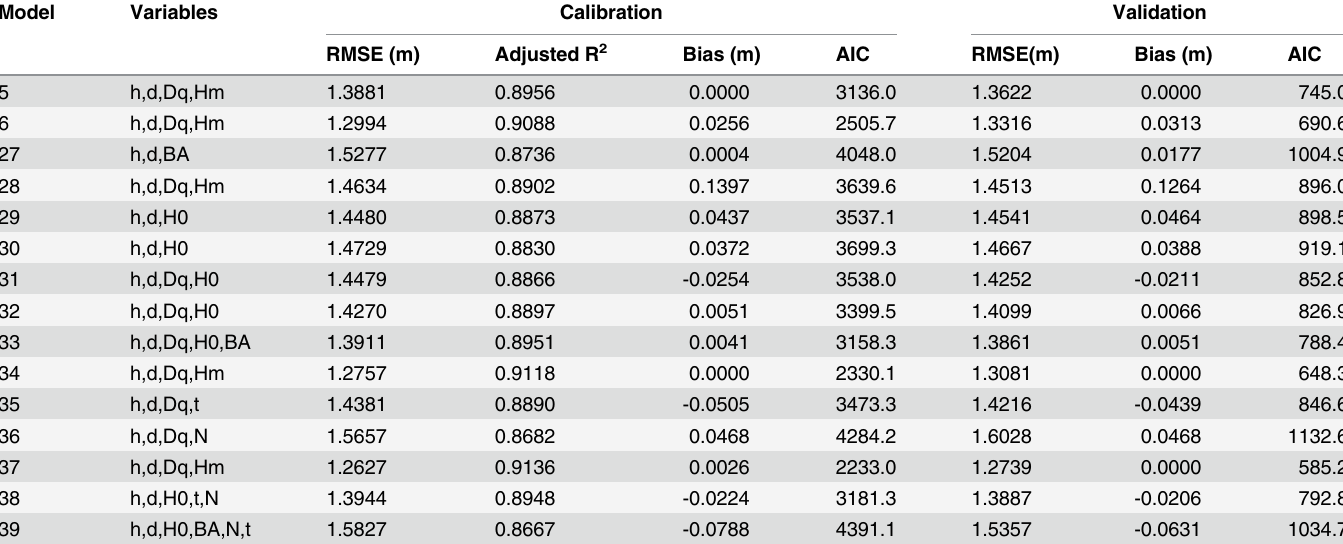
Table 4. Fitting statistics for Group 2 models using both calibration and validation datasets.